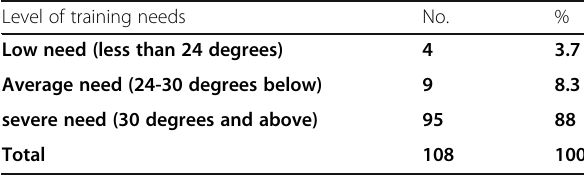
Table 4 Distribution of extension agents according to